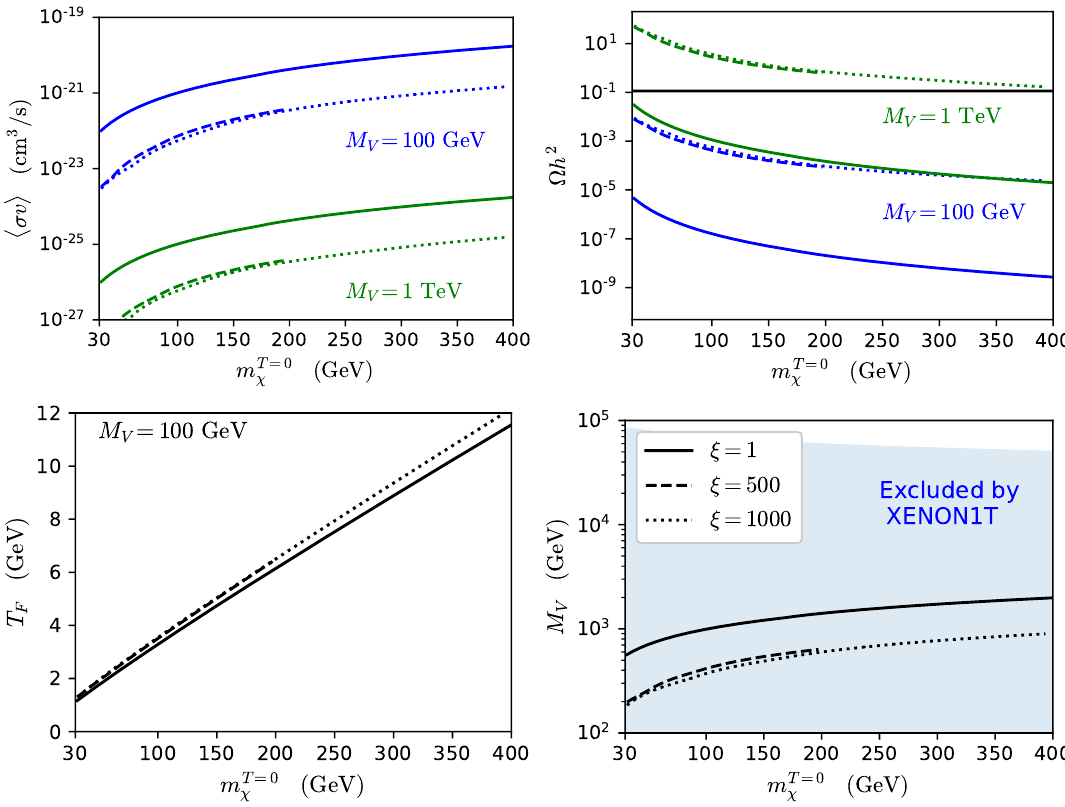
(GeV) Figure 5 . (Top left) The thermally-averaged cross-sections at the time of freeze-out as a function of m T =0 plotted for M V = 100 GeV (blue), 1 TeV (green) and (cid:24) =1 (solid), 500 (dashed), 1000 (cid:31) (dotted). (Top right) The generated relic abundance today as a function of m T =0 plotted for (cid:31) M V = 100 GeV (blue), 1 TeV (green) and (cid:24) =1 (solid), 500 (dashed), 1000 (dotted). The horizontal solid line is the observed dark matter abundance. (Bottom left) The freeze-out temperature as a function of m T =0 with M V = 100 GeV plotted for (cid:24) =1 (solid), 500 (dashed), 1000 (dotted). (cid:31) (Bottom right) Coupling as a function of m T =0 to produce the observed relic density plotted for (cid:31) (cid:24) =1 (solid), 500 (dashed), 1000 (dotted). Shaded blue region is excluded by XENON1T. See text for